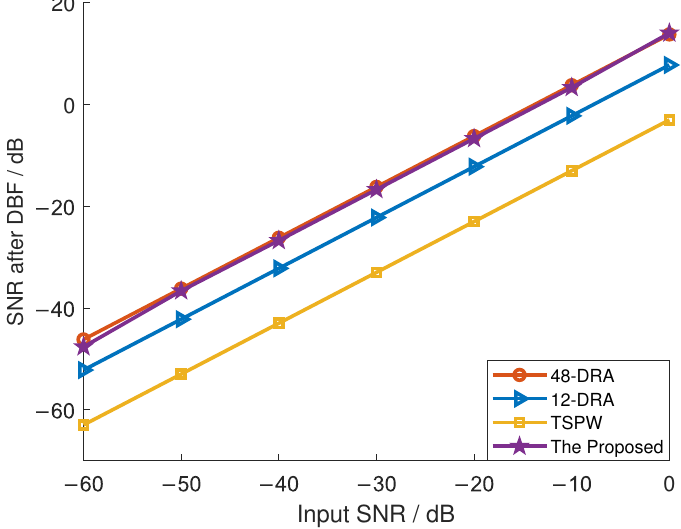
Figure 6. The SNR after DBF with different input SNR